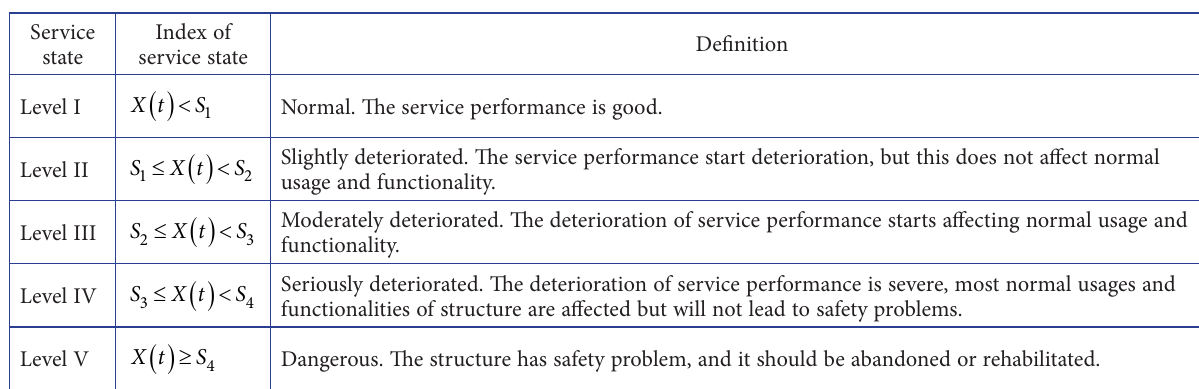
Table 1. Multi-levelled service state of structure